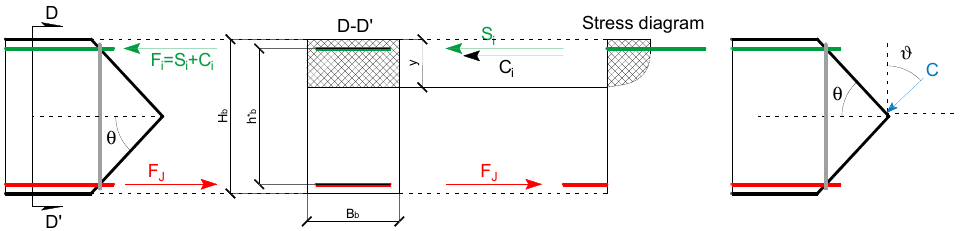
Figure 3. Analysis of compressive forces, F i , components in concrete, C i , reinforcement, S i , and compressive forces, C, in joint core (inclination 𝜃 for cracked portion and 𝜗 for C).